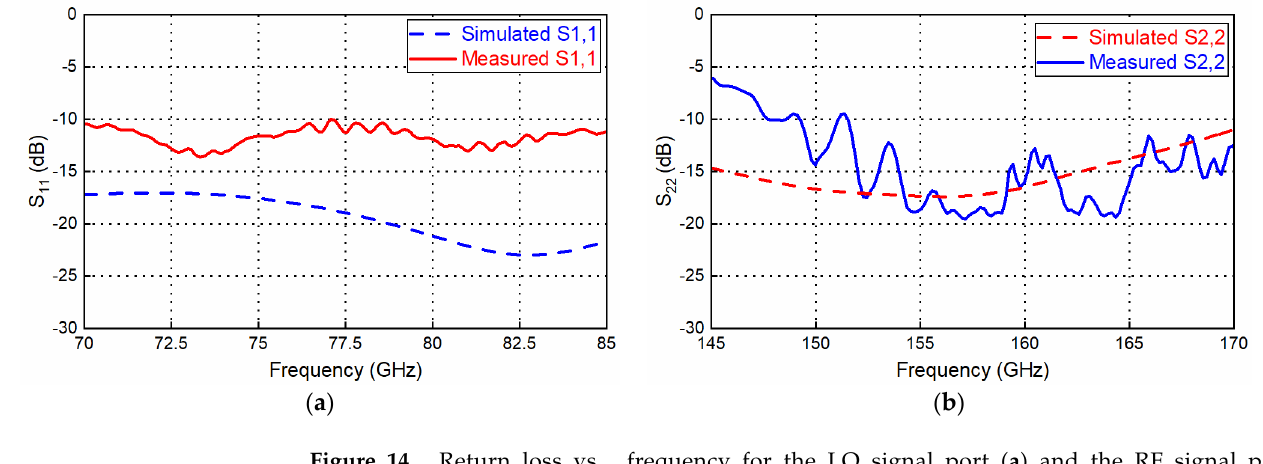
Figure 14. Return loss vs. frequency for the LO signal port ( a ) and the RF signal port ( b ) ① matching load. Table 4. Measurement comparison of D-band